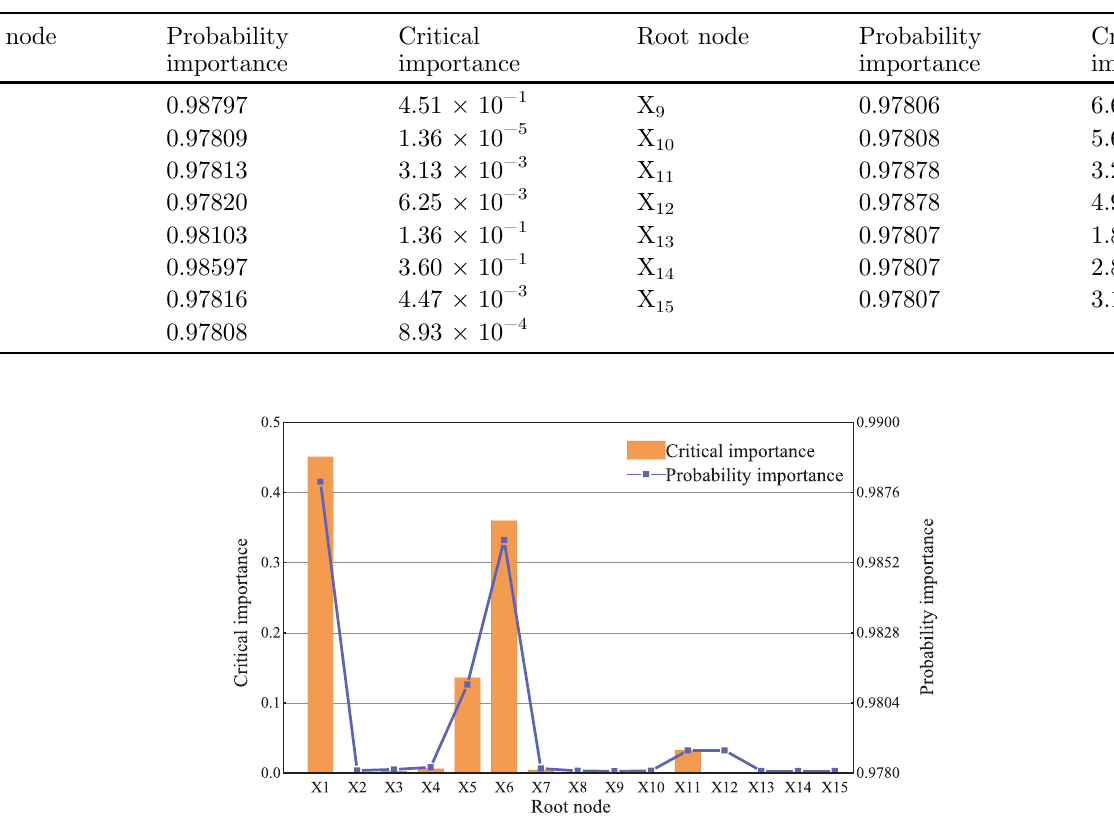
Fig. 9. Line chart of root node